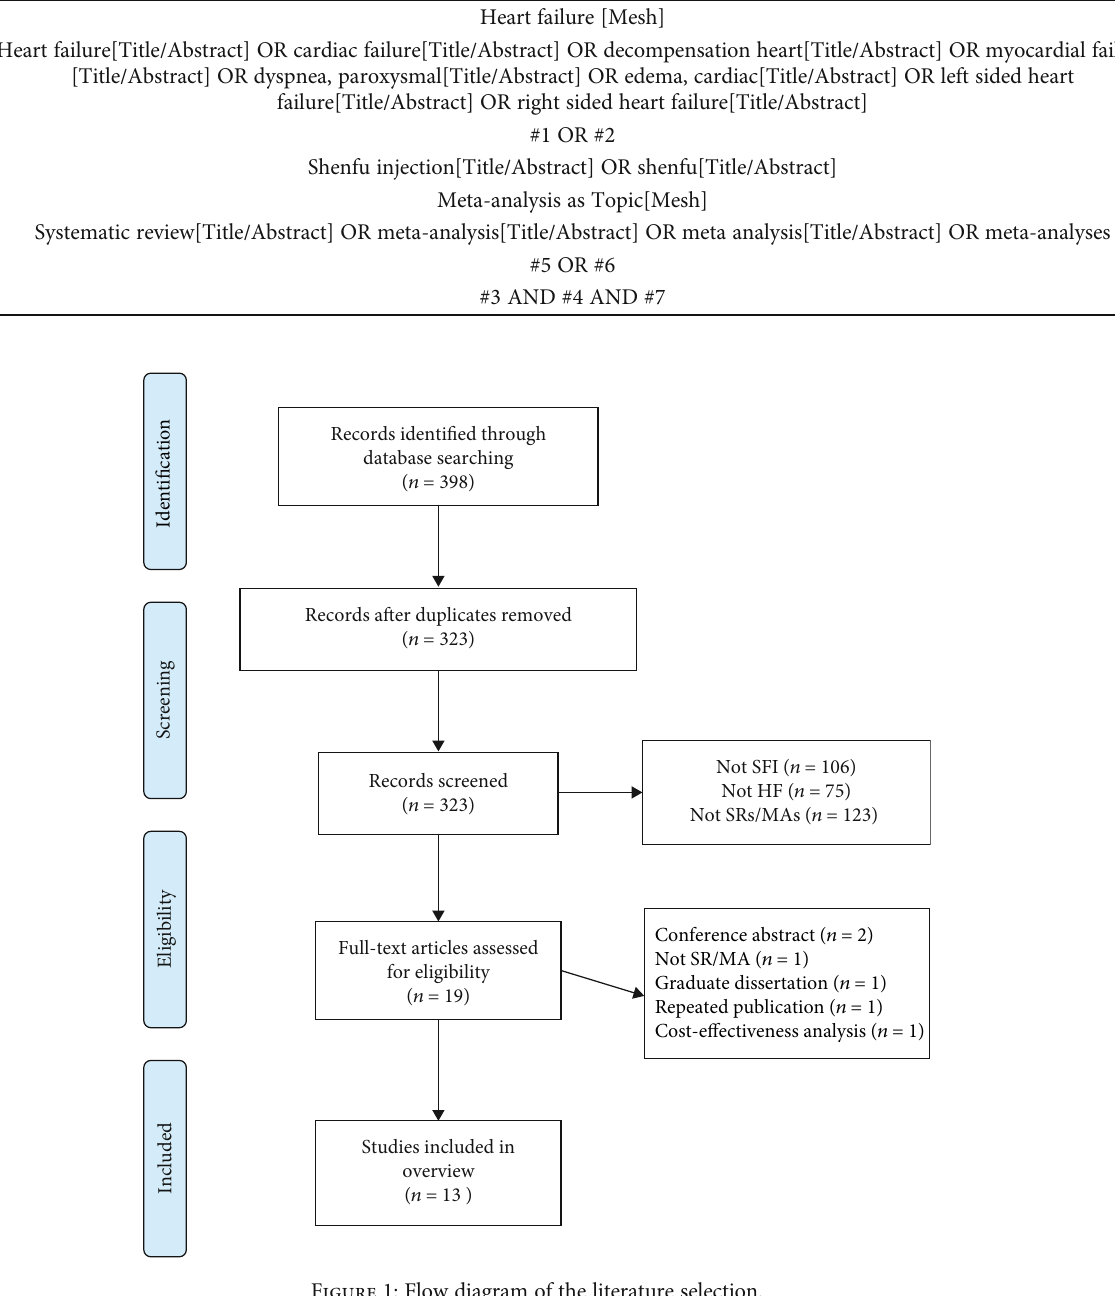
Figure 1: Flow diagram of the literature